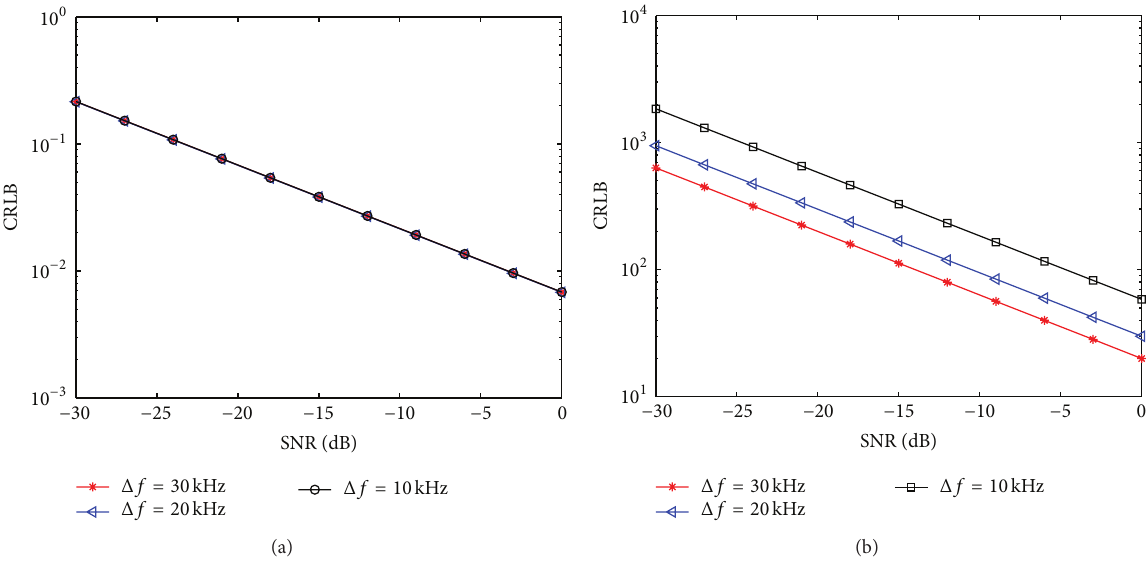
Figure 6: Comparative CRLB results for FDA MIMO radar with different Δ𝑓 : (a) angle estimation and (b) range